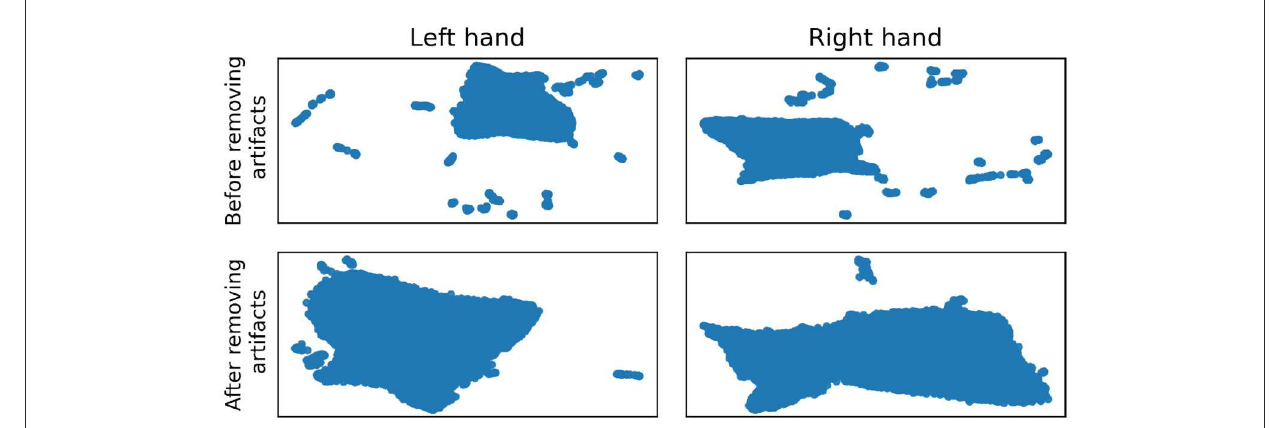
FIGURE2 Per hand embeddings before (top row) and after (bottom row) artifacts removal.